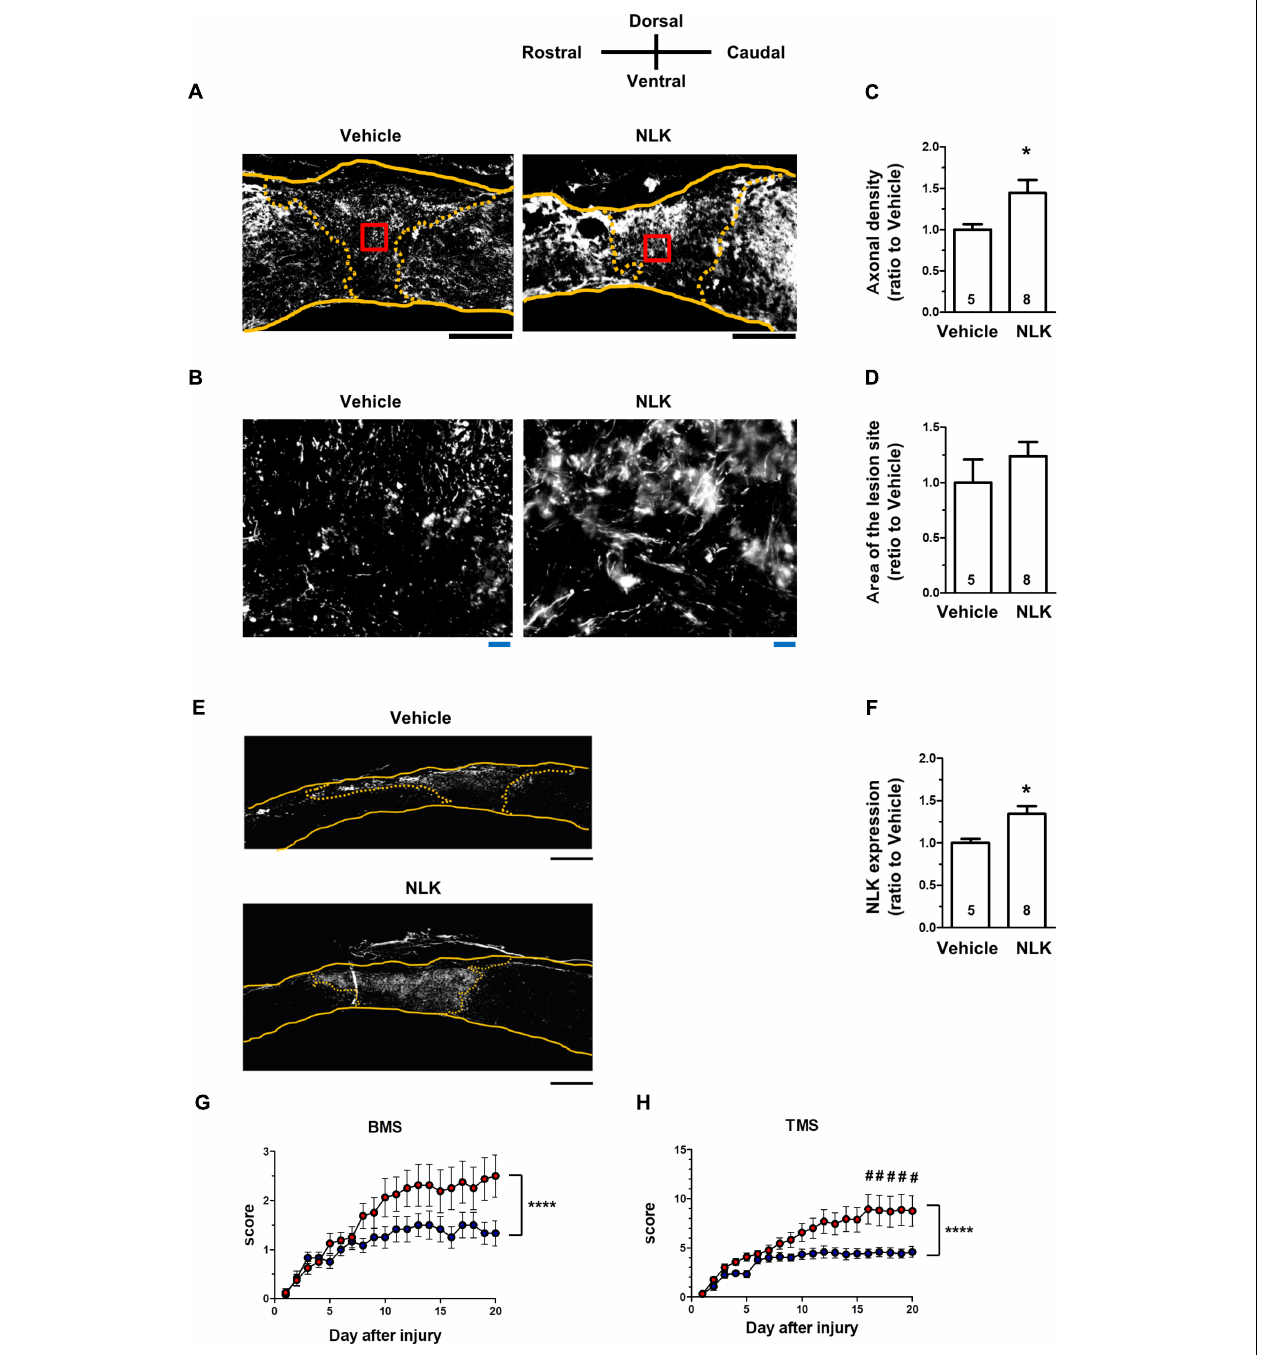
FIGURE 5 | Injection of neuroleukin (NLK) into the injured site in spinal cord injury (SCI) mice induced axonal growth and improved motor function. SCI mice received microinjection of NLK (red circles, 8 mice, 16 hindlimbs, n = 16) or vehicle (blue circles, 6 mice, 12 hindlimbs, n = 12) within 15 min after injury. Twenty days after injury, spinal cords were collected and sagittal sections of the spinal cords were immunostained for phosphorylated neurofilament-H (pNF-H), glial fibrillary acidic protein (GFAP), and NLK. Representative immunofluorescence images of pNF-H (A) and NLK (E) are shown. Areas enclosed with red lines in (A) are magnified in (B) . The yellow lines show the outline of the spinal cords. The yellow dotted lines indicate the border of the glial scar region judged by immunostaining for GFAP. Density of pNF-H-positive axons (C) , size of the lesion site (D) and the expression level of NLK inside the lesion site (F) were quantified. ∗ p < 0.05, vs. vehicle, unpaired two-tailed t -test. Black scale bars = 500 µ m (A,E) , Blue scale bars = 20 µ m (B) . Hindlimb motor function was evaluated using the Basso mouse scale [BMS (G) ] and Toyama mouse score [TMS (H) ]. ∗∗∗∗ p < 0.0001 vs. Vehicle, drug × day interaction by repeated measures using two-way ANOVA. # p < 0.05, vs. vehicle at each time point, post hoc Bonferroni